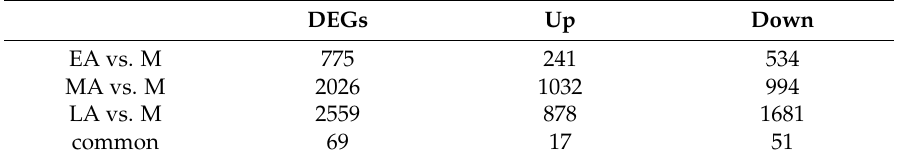
Table 3. Differentially expressed genes (DEGs) in different stage of premature senescence compared with M. DEGs